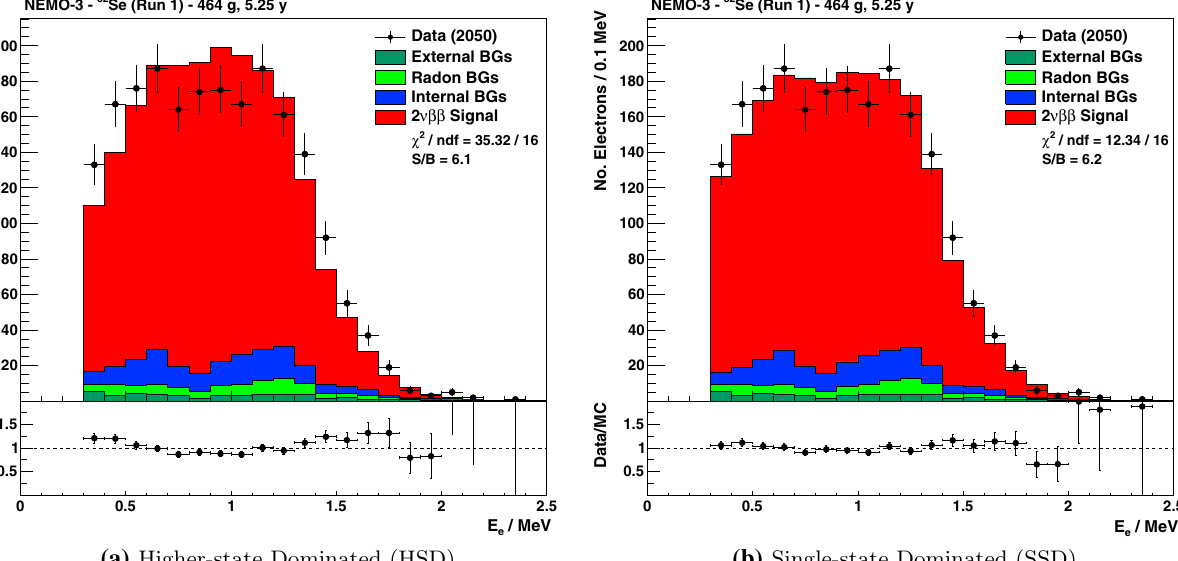
Fig. 7 Energy distribution of individual electrons in the ββ chan- nel for foils from enrichment run 1, after removing events where Σ E < 1 . 6MeV to reduce the effect of contamination by 234m Pa. e The data are compared to the predicted spectrum from MC under the